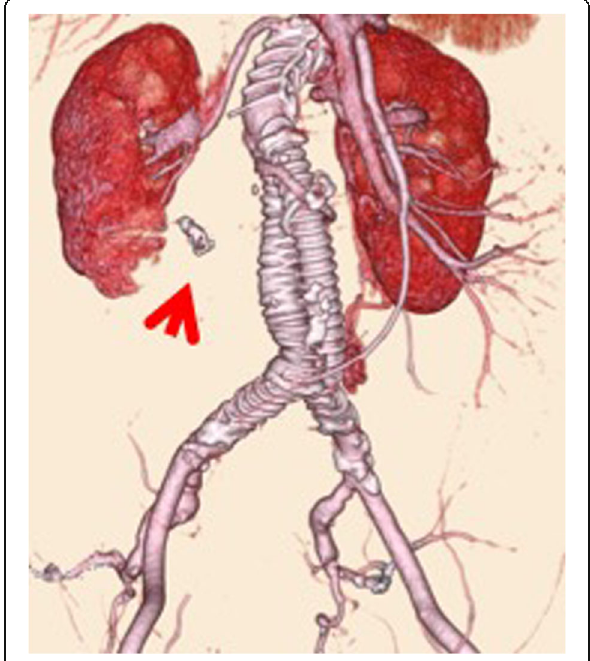
Fig. 3 Post-operative enhanced CT. There was no type II endoleak from the ARA. The distal portion of the ARA from the coils was well perfused ( arrow ) and the right kidney was not